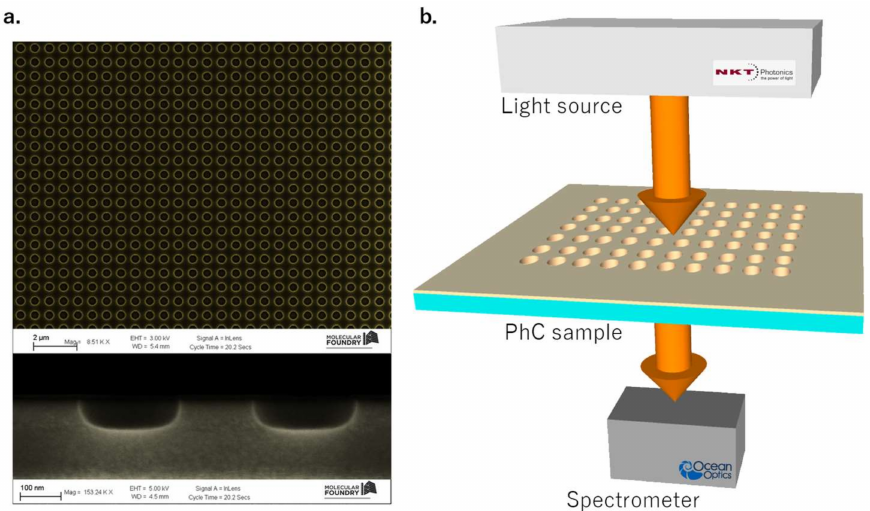
Figure 1. ( a ) Scanning electron microscopy image of the photonic crystal (PhC) sample. The design consists of air-cylindrical holes arranged in a square lattice ( a = 521 nm, r = 130 nm, h = 78 nm). ( b ) Sketch of the experimental